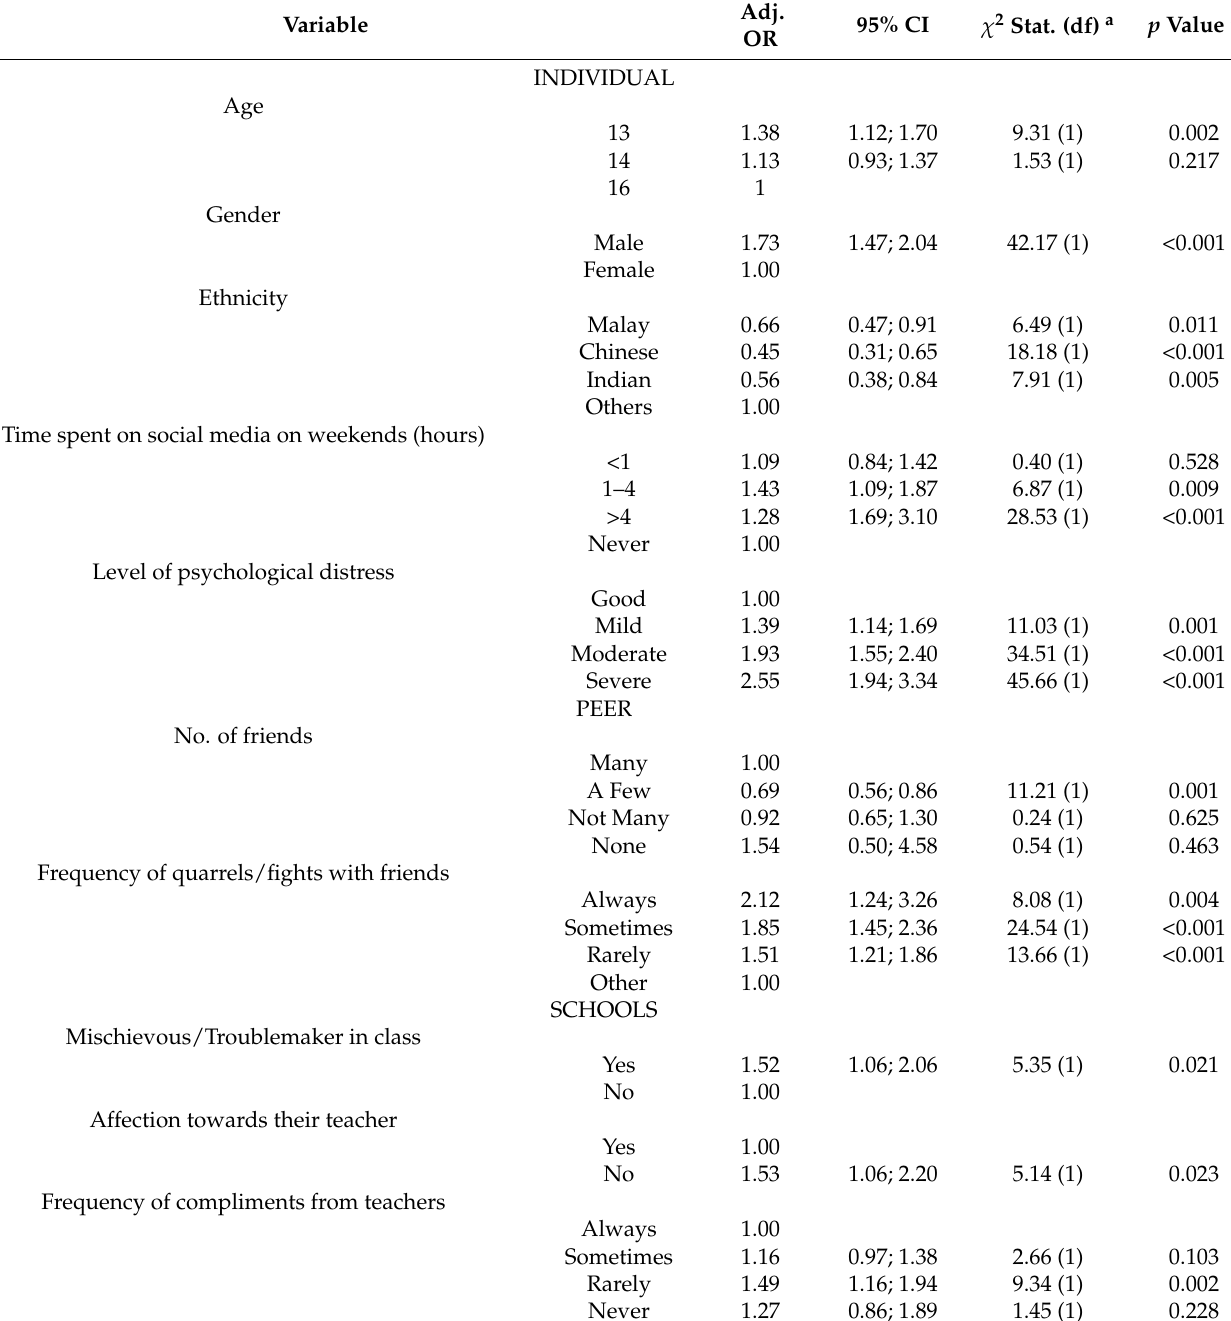
Table 12. Determinant factors of bullying